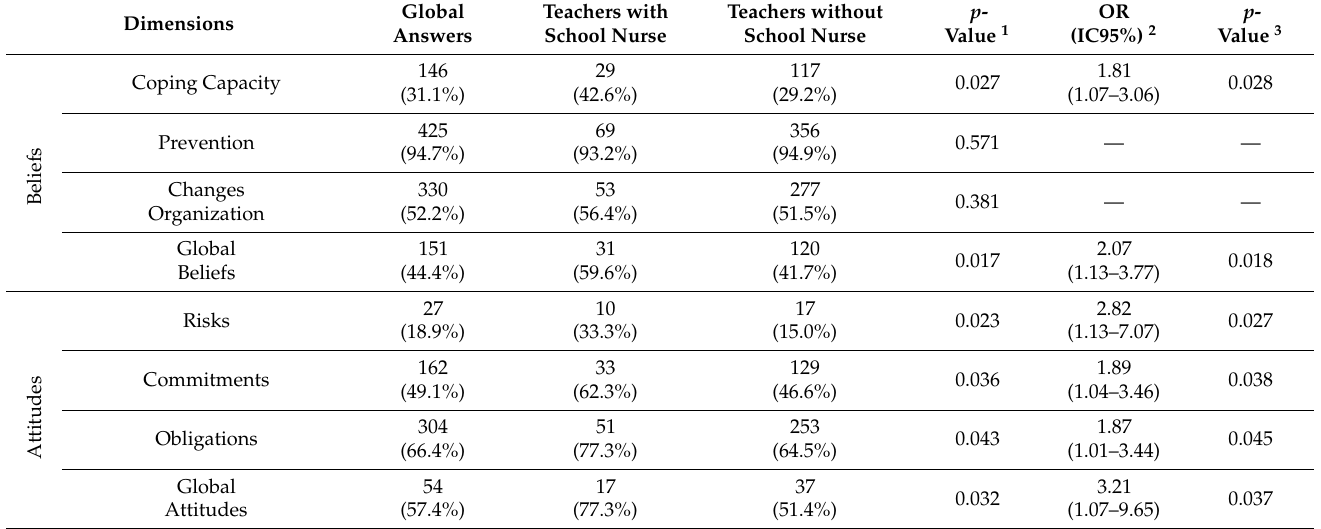
Table A5. Answers given to the dimentions of the questionnaire globally and according to whether or not the teachers have a health professional in their educational